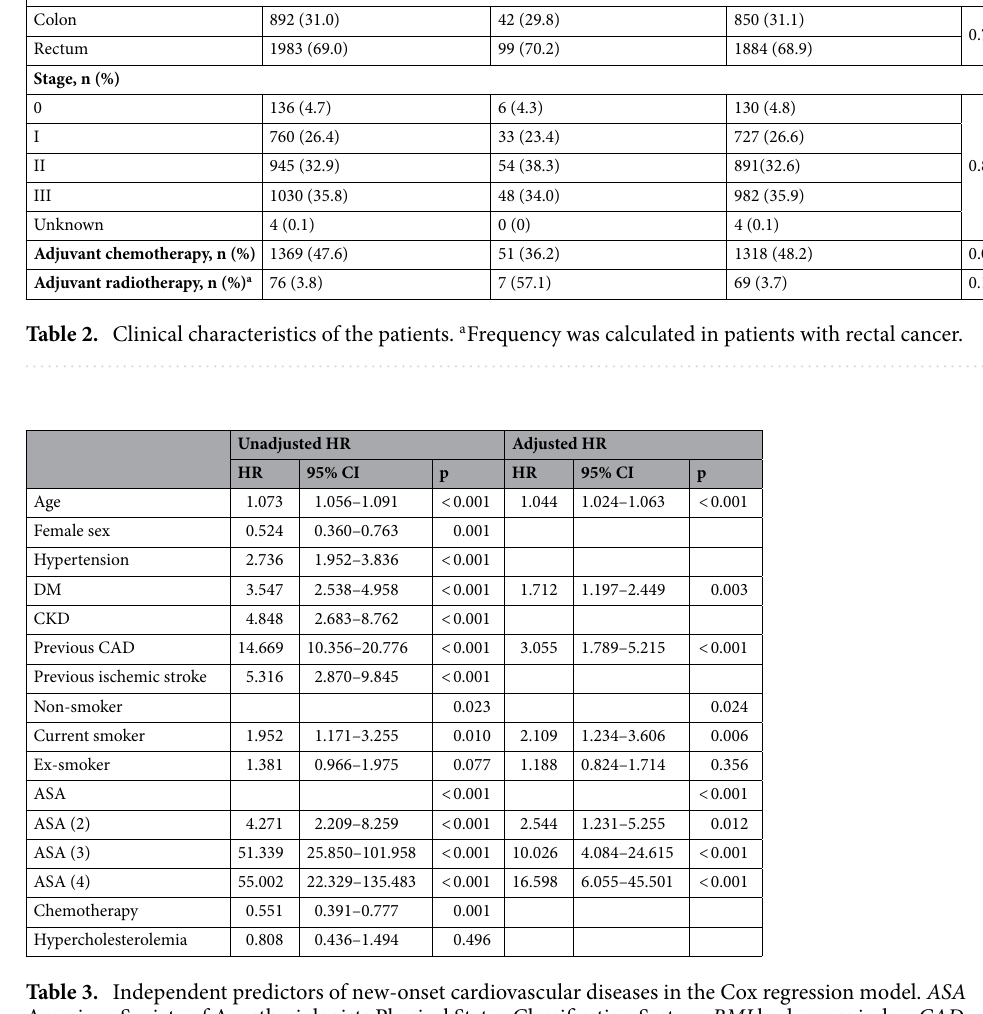
Table 3. Independent predictors of new-onset cardiovascular diseases in the Cox regression model. ASA American Society of Anesthesiologists Physical Status Classification System, BMI body mass index, CAD coronary arterial disease, CI confidence interval, CKD chronic kidney disease, DM diabetes mellitus, HR hazard ratio.